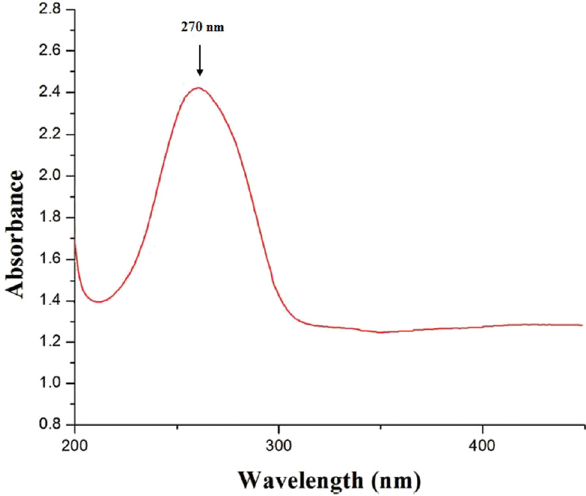
Figure 2: UV - Visible spectrum of Sp SeNPs.